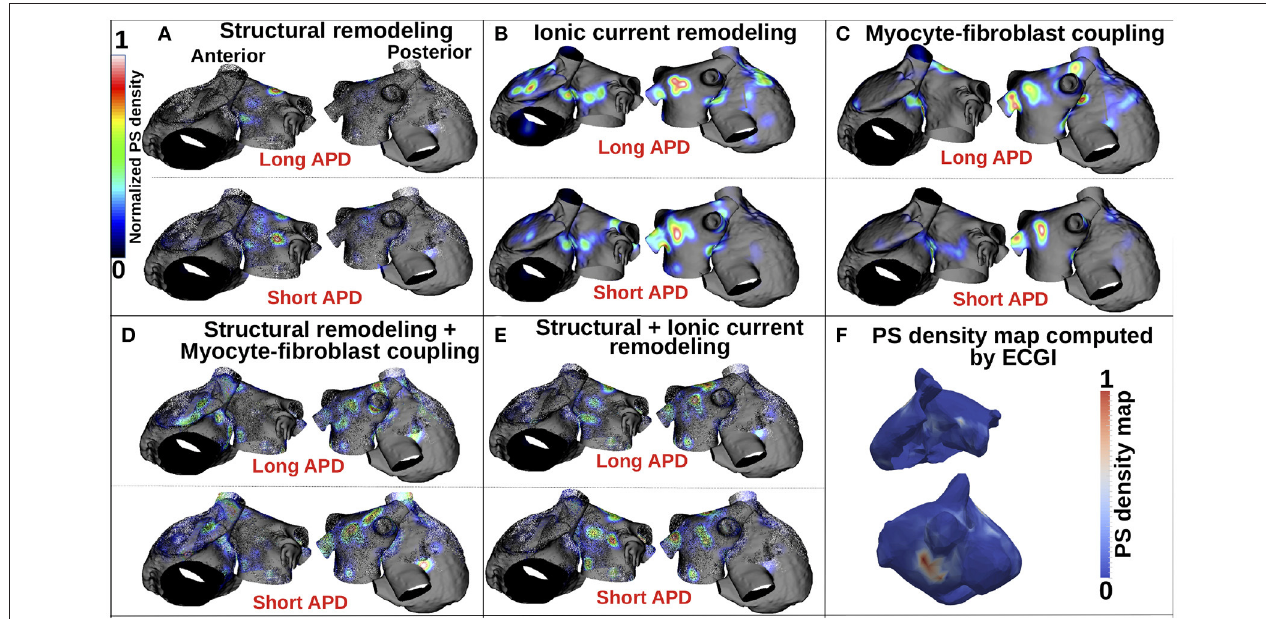
FIGURE 5 | PS density maps depend on both fibrosis implementation method and APD. (A–E) Show PS density maps for the 5 fibrosis implementation methods: structural remodeling, ionic current remodeling, myocyte-fibroblast coupling, structural remodeling + myocyte-fibroblast coupling, and structural + ionic current